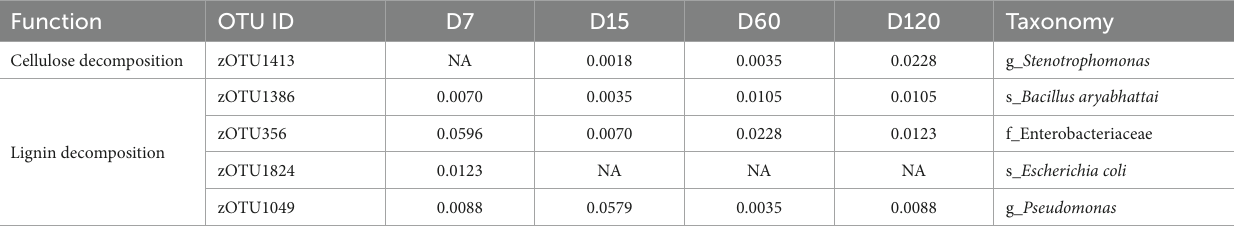
NA indicates not detected. f, g, and s indicate family, genus, and species level,